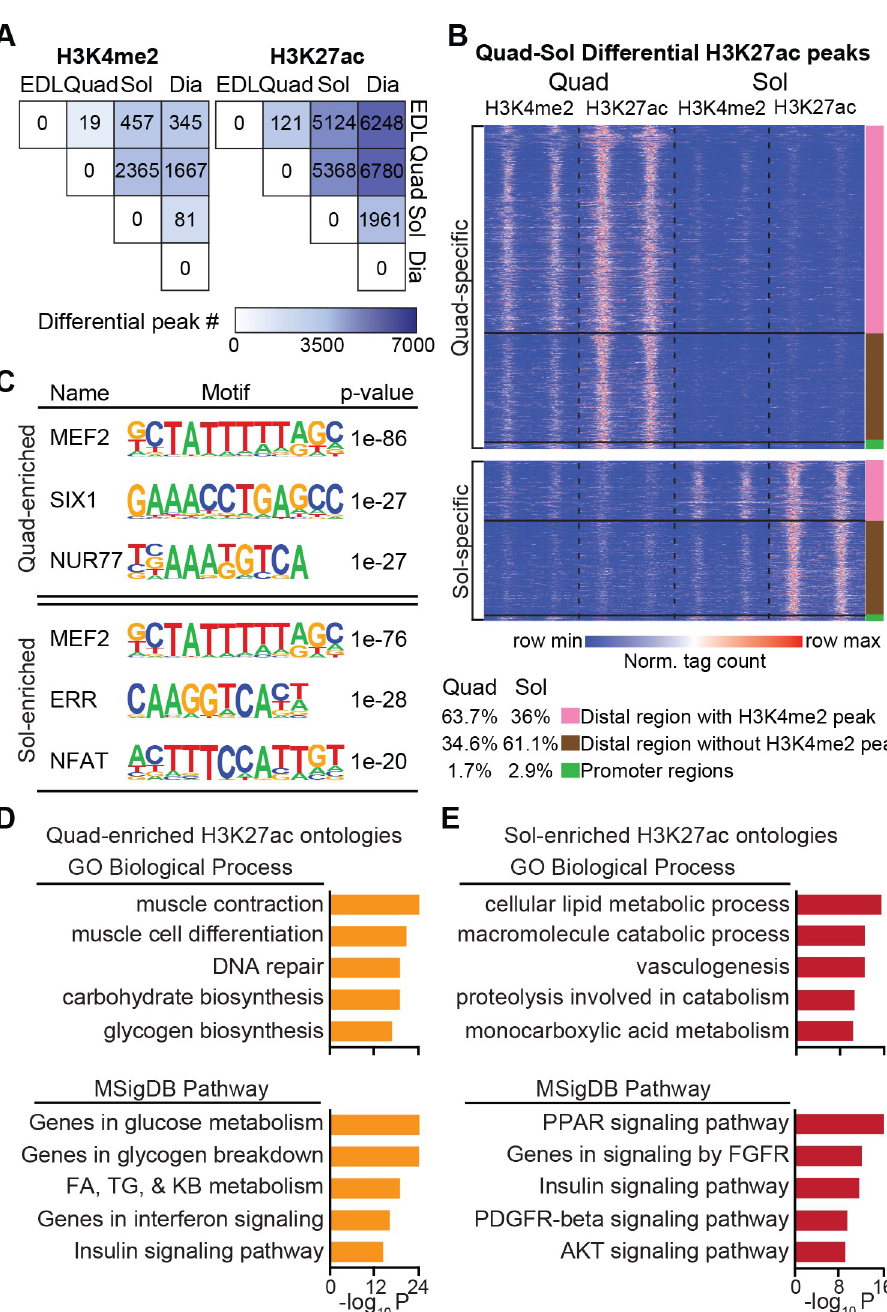
Fig 5. Enhancer regions reflect muscle group–specific function. (A) Heatmap of pairwise comparisons showing the number of differential H3K4me2 (left) and H3K27ac (right) peaks in EDL, Quad, Dia, and Sol. Differential peak number is represented by color. (B) Heatmap distribution of H3K4me2 and H3K27ac tags within 6 kb of Quad- specific (top) and Sol-specific (bottom) H3K27ac peaks in Quad and Sol; n = 2/group. Color bars on the right correspond to promoter regions, promoter-distal regions with H3K4me2 peaks, or promoter-distal regions without H3K4me2 peaks. (C) Top three motifs enriched within H3K27ac peaks in Quad compared with Sol (top) and Sol compared with Quad (bottom). (D, E) Top five categories of genes annotated to H3K27ac peaks specific to Quad (D) or Sol (E), respectively. Numerical values for panels A, C, D, and E are available in S1 Data, and numerical values for panel B are available in S10 Data. AKT, protein kinase B; Dia, diaphragm; EDL, extensor digitorum longus; FA, fatty acid; FGFR, fibroblast growth factor receptor; GO, gene ontology; H3K4me2, histone 3 lysine 4 dimethylation; H3K27ac, histone 3 lysine 27 acetylation; KB, ketone body; MSigDB, Molecular Signatures database; MEF,